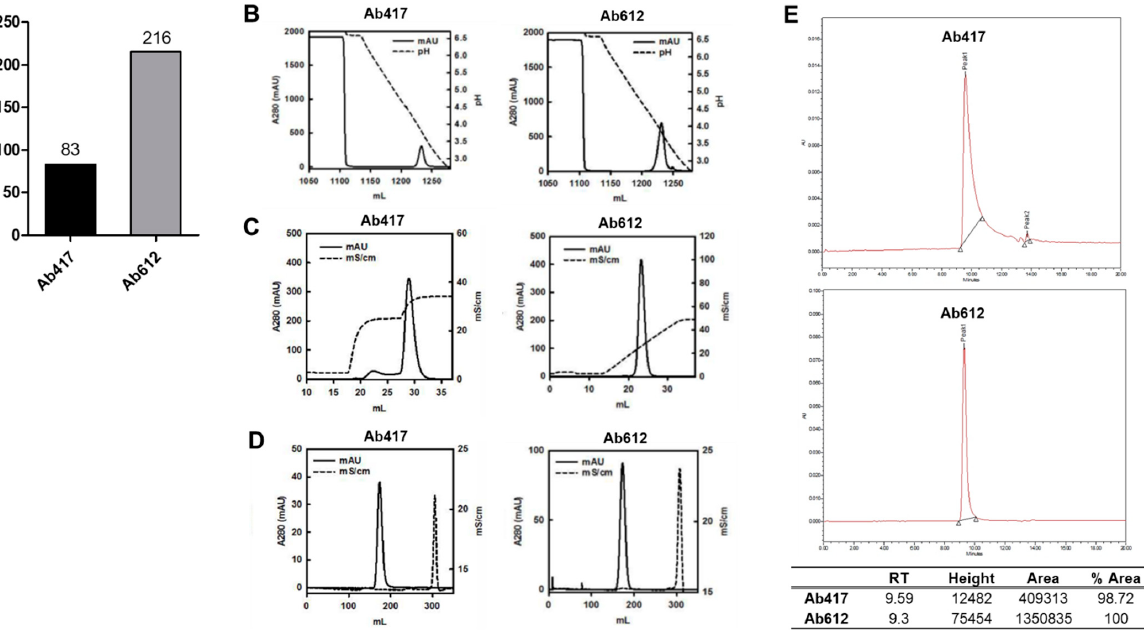
Figure 2. ( A ) Expression levels of antibodies using the ExpiCHO transient expression system. ( B , C ) Ab417 and Ab612 were purified by protein A affinity chromatography ( B ) and CIEX by stepwise gradient elution and linear gradient elution, respectively ( C ). ( D ) Final polishing was conducted using SEC. ( E ) SEC-HPLC of each antibody was performed to determine the purity and homogeneity following purification.